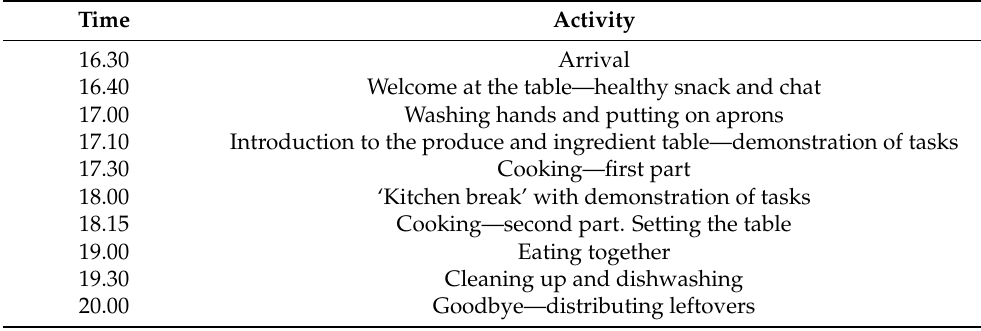
Table 1. Schedule for the cooking classes.